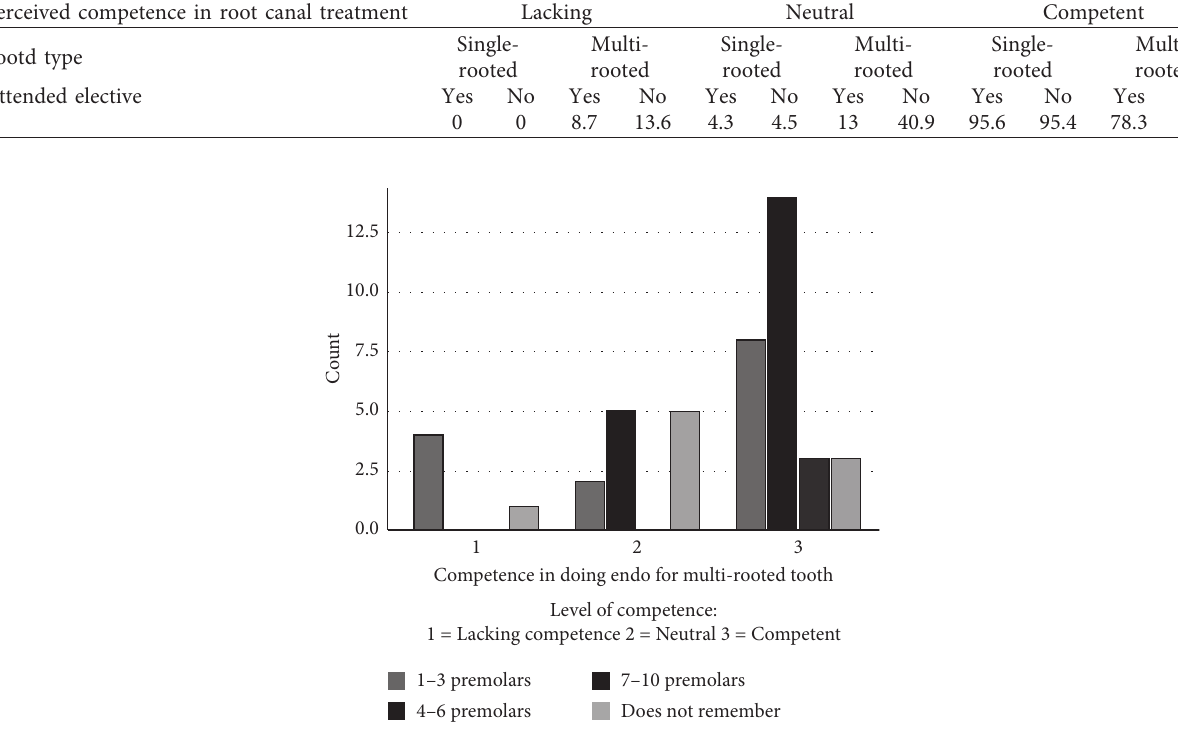
Figure 1: Number of treated premolars and perceived level of